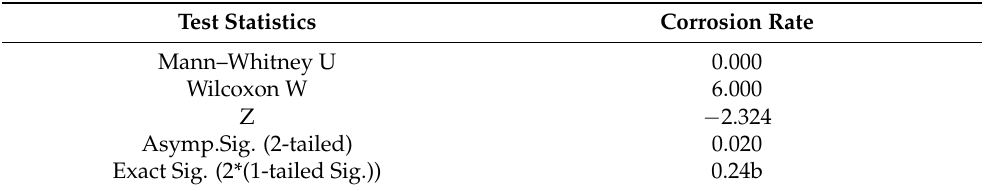
Table 5. Statistical analysis, CR Dulbecco vs. In